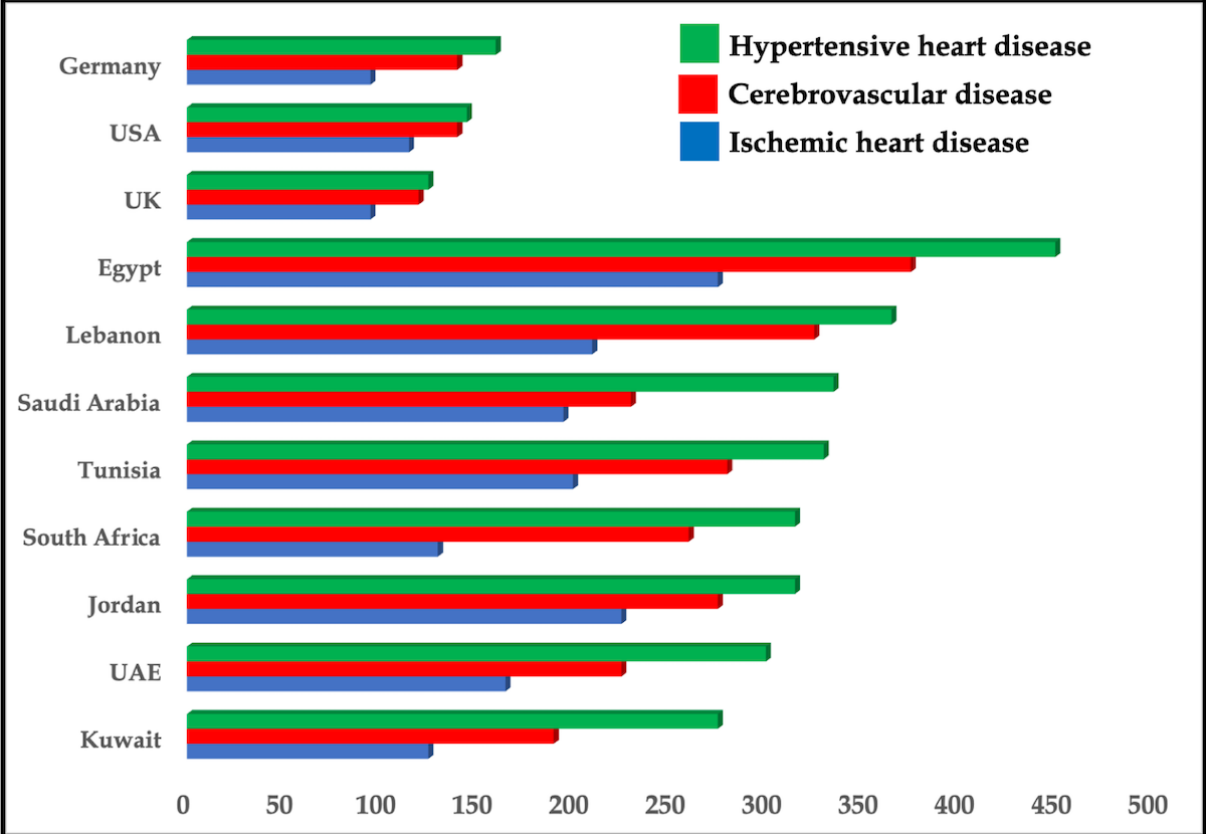
Figure 2. Death rates (ie, number of deaths per 100,000 people) from vascular diseases in selected countries in Africa and the Middle East compared to western countries. Drawn from data presented by the World Health Organization. UAE: United Arab